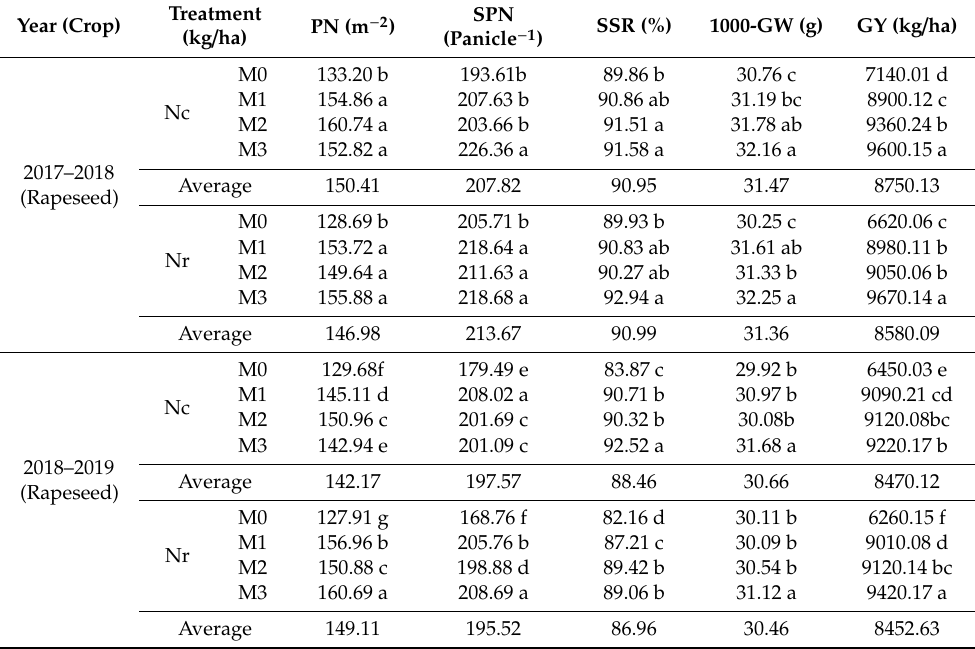
Table 2. E ff ect of N Rate in Rapeseed Season and N Management in Rice Season on the Hybrid Rice. Year